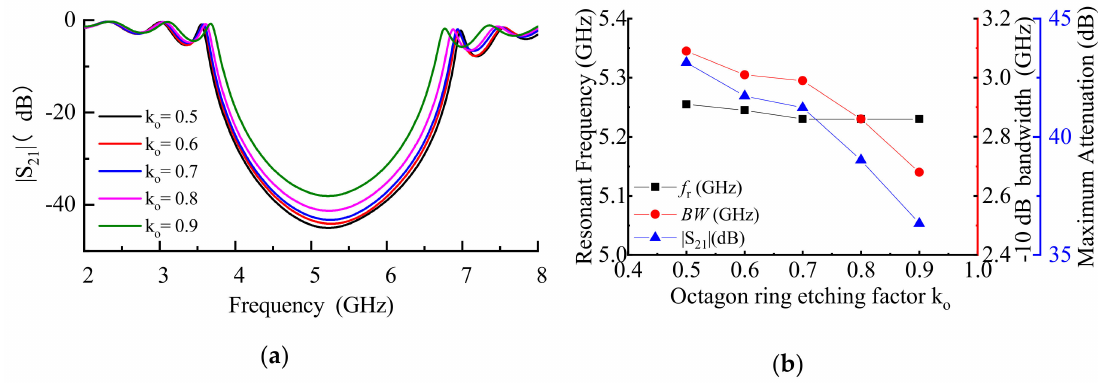
Figure 13. ( a ) Simulation with di ff erent k o by using HFSS; ( b ) maximum attenuation and − 10 dB fractional bandwidth with di ff erent k o